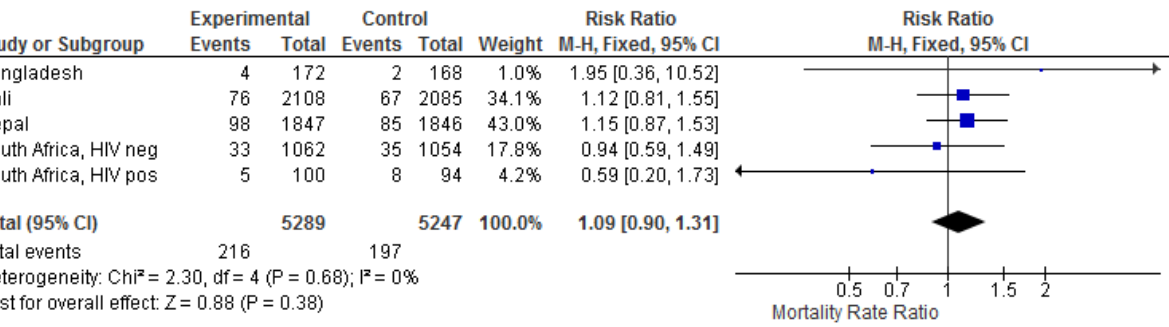
6 of 11 Figure 2. The effect of influenza vaccination in pregnancy on maternal non-influenza infectious adverse events. In Bangladesh, this was reported as hospitalisations. The following were considered infectious: fever; appendicitis; diarrhoea. In Mali, this was reported as serious adverse event. The following were considered infectious: chorioamnionitis; serious infection in pregnancy; peritonitis. In South Africa, this was reported as hospitalisations for infections. Among HIV-positive cohort, hospitalisation due to TB in the control group was excluded, as it was assumed as being pre-existing.